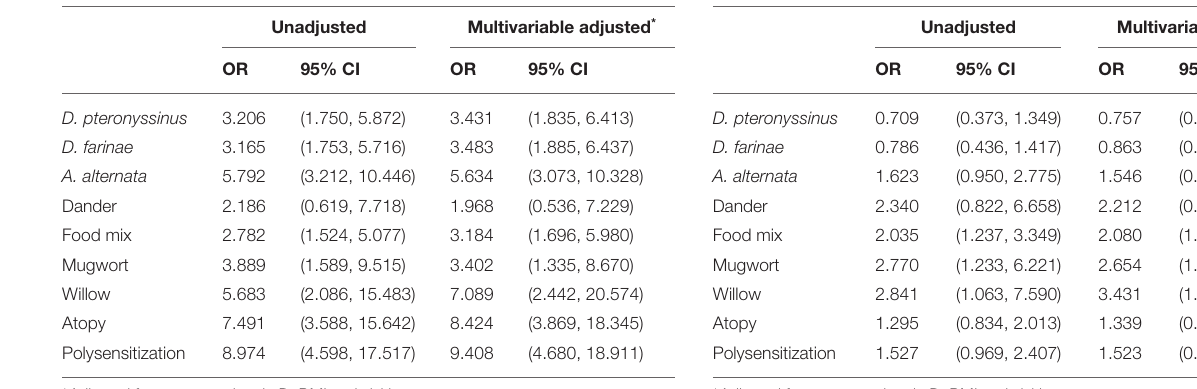
TABLE 3 | Associations of eosinophilia with atopy. TABLE 4 | Associations of basophilia with